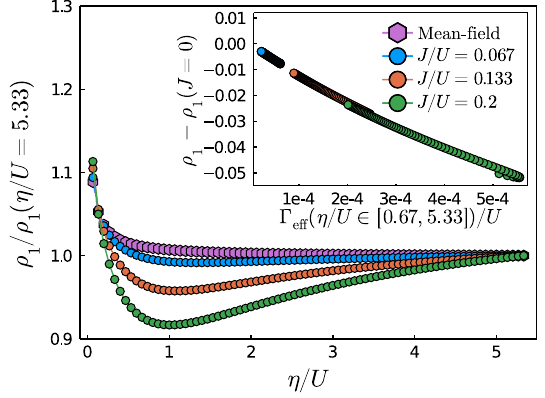
FIG. 3. Emergence of a quantum-Zeno regime at fixed drive rate f=U ¼ r η =U ¼ 0 . 013 z ¼ 6 , U ¼ 15 andincreasingtwo-particle- 20 , dt ¼ 0 . 002 , and dim 6 . loss rate η . Parameters: t H ¼ max ¼ Probability of having one boson per site in the steady state ρ 1 as a function of η =U , rescaled by its value at η =U ¼ 2 . 67 for conven- ience. It follows a nonmonotonic behavior with a minimum at η ¼ U , which is more pronounced the larger the hopping J . This behavior is a manifestation of quantum-Zeno physics, controlled by the hopping-induced loss rate Γ as we show clearly in the eff inset, which is instead completely missed by